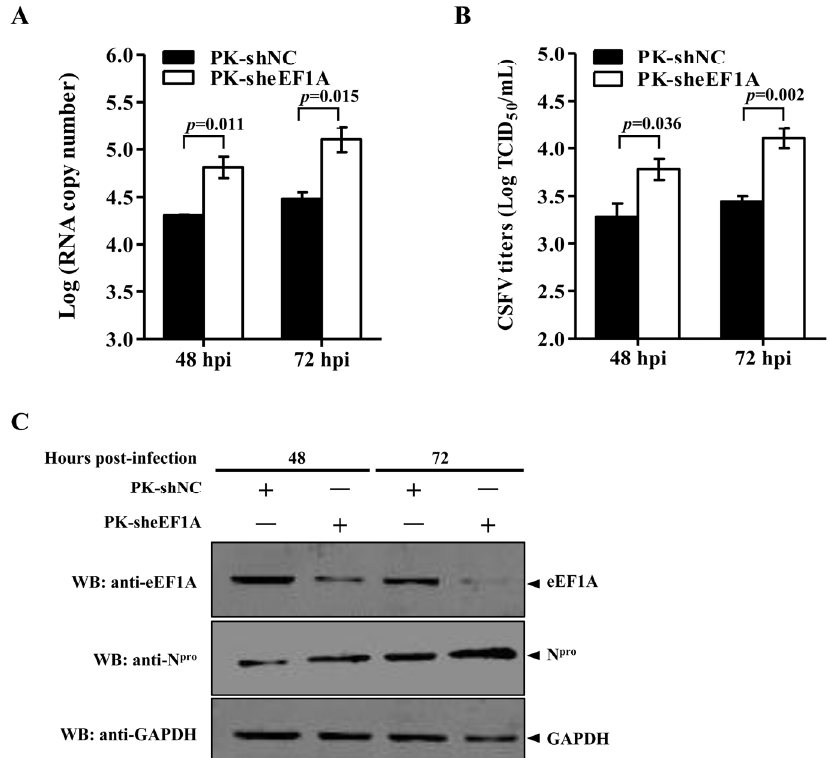
Figure 4. Knockdown of eEF1A increases CSFV growth. ( A ) CSFV genome copies